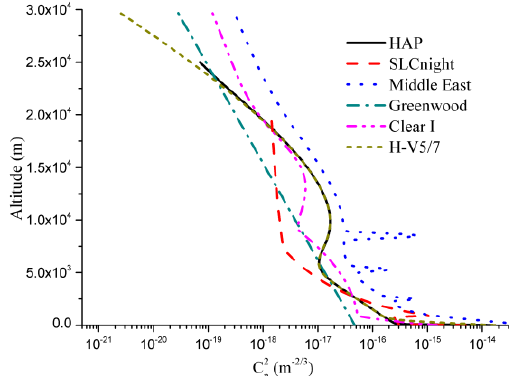
Figure 4. Turbulence profiles with various typical models. The deviation of μ 2 , Dev , is given by: